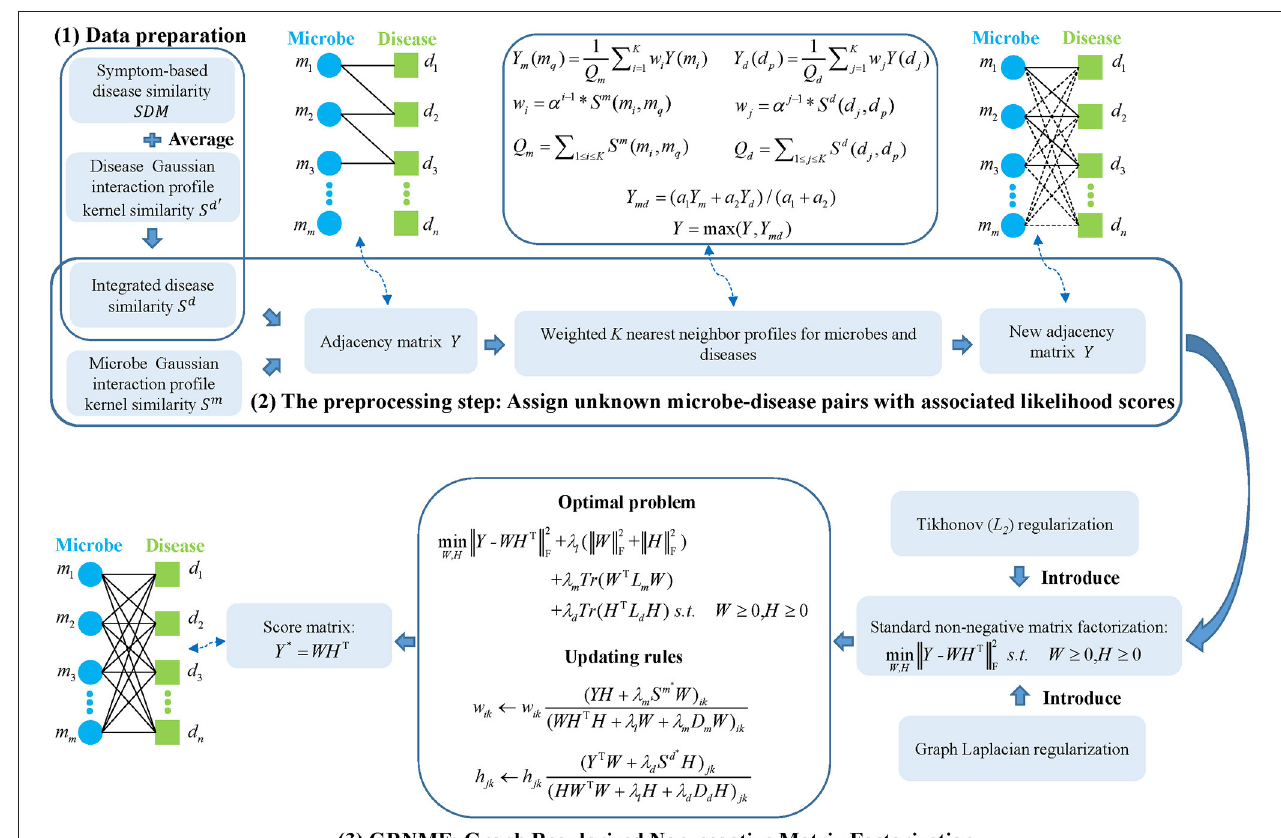
FIGURE 1 | Flowchart of GRNMFHMDA model to predict the potential microbe-disease associations.